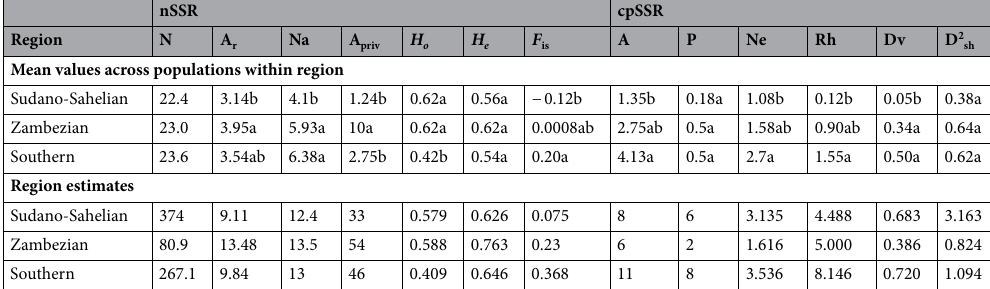
Table 1. Sub-range genetic diversity estimates at ten nuclear SSR loci and two cpSSR loci for Senegalia senegal in three biogeographic regions . Given are the mean values across populations (with different letters indicating significant differences according to ANOVA and posthoc test) and region estimates in which regions are treated as populations. See Supplemental Table S3 for population level estimates. N, number of samples per location; A r, rarified allelic richness (Mousadik and Petit, 1996); Na, mean number of alleles per locus per population; H o , observed heterozygosity; H e , expected heterozygosity; A priv , number of private alleles; F is , inbreeding coefficient; A, number of haplotypes; P, number of private haplotypes; Ne, effective number of haplotypes; Rh, haplotypic richness; Dv, genetic diversity; D 2 sh , mean genetic distance between